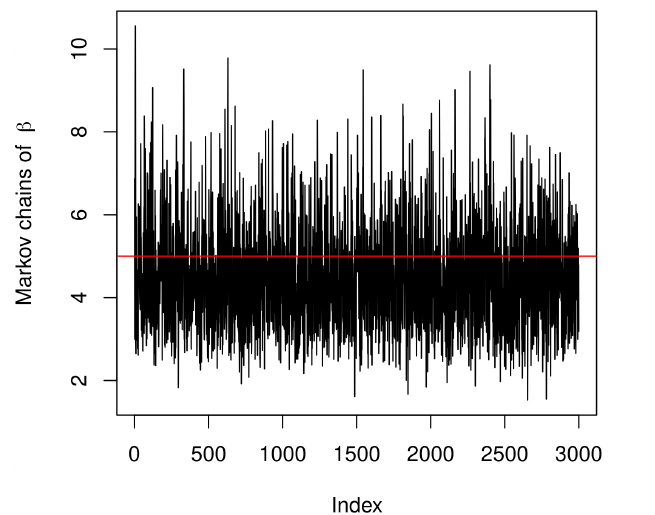
Figure 1. The Markov chains of β . The horizontal line is the true value of β